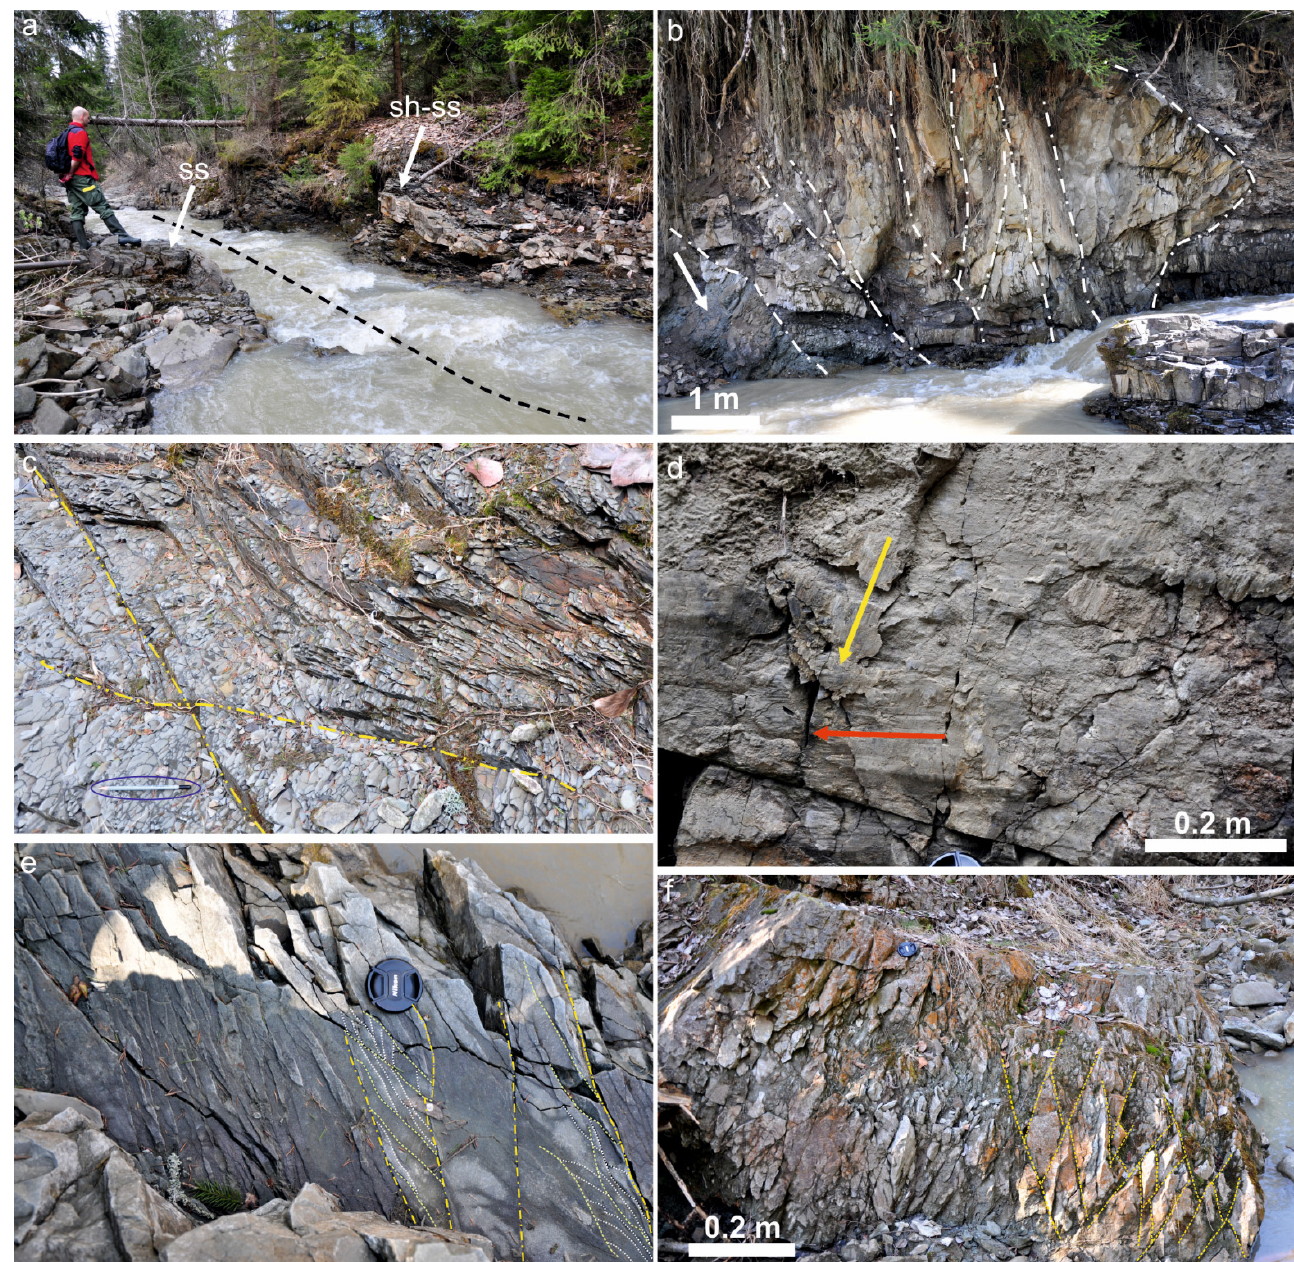
Figure 12. Outcrop fault indicators: ( a ) discontinuity in lithology on the opposite river banks (black dashed line)—shale- sandstone packet of layers on the right (sh-ss) and thick sandstone layer on the left (ss), ( b ) thick-bedded sandstones of the Magura Fm. densely fractured sandstones (white dashed line) with clay mineral veins and bleaching colours resulted due to the cement alteration during fluid migration indicated by an arrow, ( c ) scaly fabric in shales, pervasive in fault zone, almost no visible sedimentary bedding of shales due to many intersecting, sharply defined shear surfaces (yellow lines), ( d ) two generations of the slickensides, coated by mineral fibres, indicating strike-slip (red arrow) and dip-slip (yellow arrow) sense of movement, ( e ) upper surface of sandstone layer showing several generations of splay joints—initial sheared joints marked with thicker dashed lines, first generation of splay joints with dotted yellow lines, and secondary splay joints with white dotted lines, ( f ) fracture network (yellow lines) in the competent rock (sandstone) causing its fragmentation into rhomboidal pieces.